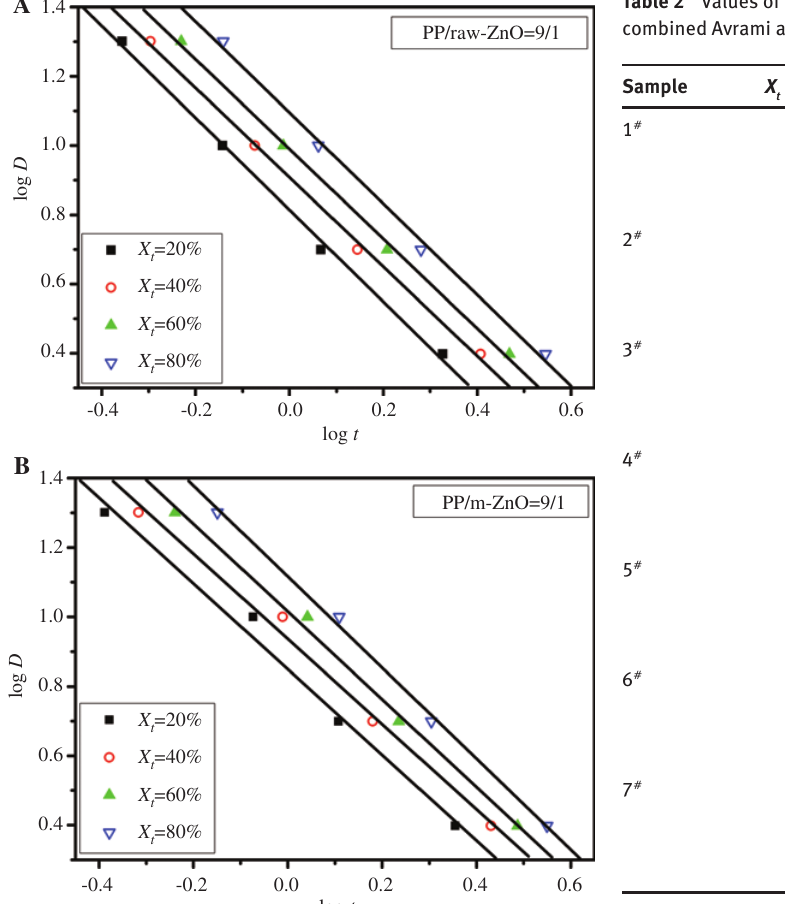
Figure 5 Curves of lg D versus lg t at different relative degrees of crystallization of the PP/ZnO composites; (A) PP/raw-ZnO and (B) PP/m-ZnO.